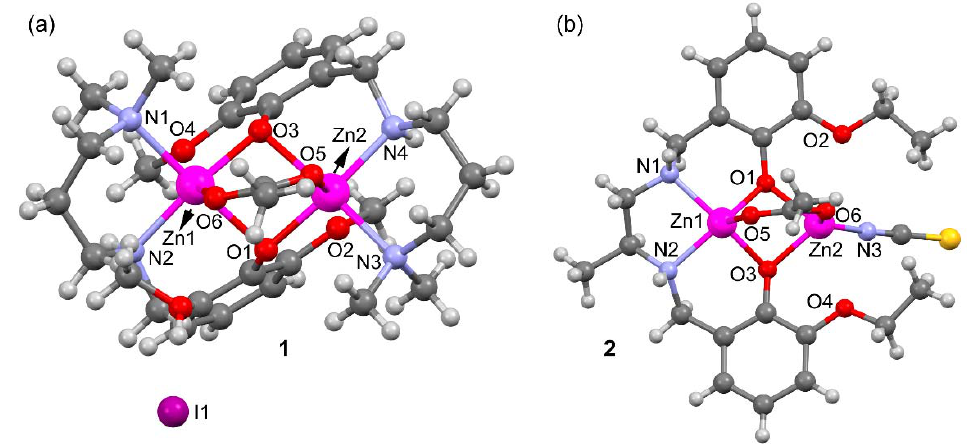
Figure 2. Perspective ball and stick view of the complexes 1 ( a ) and 2 ( b ) along with selective atom numbering scheme (only the coordinating atoms are labeled for clarity).